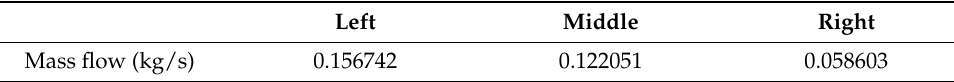
action of the guide plates is shown in Table 1. It can be seen from Table 1 that under the effect of the existing guide plates, the air inlet flow of each guide channel decreases from left to right, and there is a big difference in the air inlet flow between the left and right guide channels, which is 0.098139 kg/s (the difference ratio is 62.61%), which seriously affects the efficiency of flow-field circulation and the uniformity of temperature-field changes in the autoclave. Table 1. Air mass flow of each guide channel. Left Middle Right Mass flow